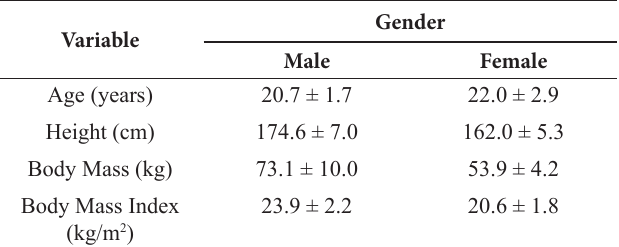
Table 1. Mean and standard deviation of the variables describing the sample (n=38).